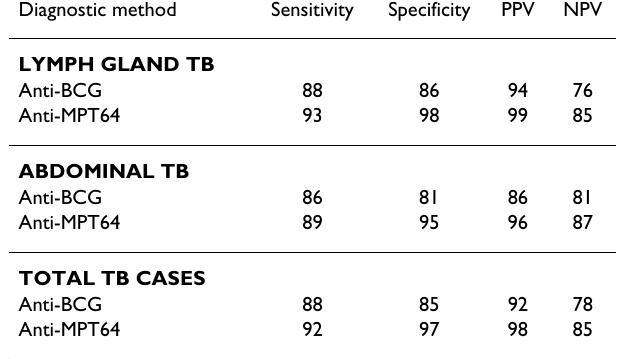
Table 4: Diagnostic validation of different tests using nested PCR as gold standard (all values are in percentage). Diagnostic